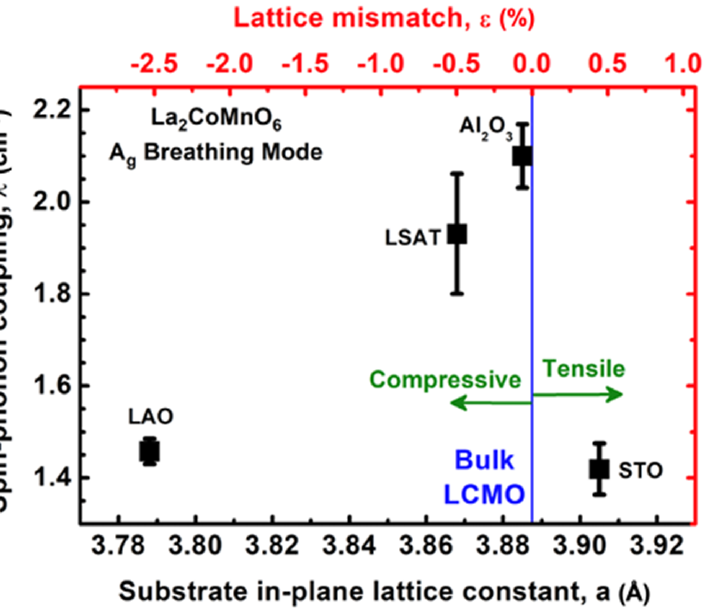
Figure 4. Spin-phonon coupling strength, λ , of the B -site ordered LCMO(111) thin films grown by MAD on different substrates, as a function of the in-plane lattice constant of the used substrates, a Sub , or of the corresponding in-plane lattice mismatch, ε = 100% ∗ (a Sub − a LCMO )/a LCMO , with respect to the lattice constant of the bulk LCMO, a LCMO = 0.3887 nm. Adopted with permission from American Physical Society (Copyright 2018) ref [5].